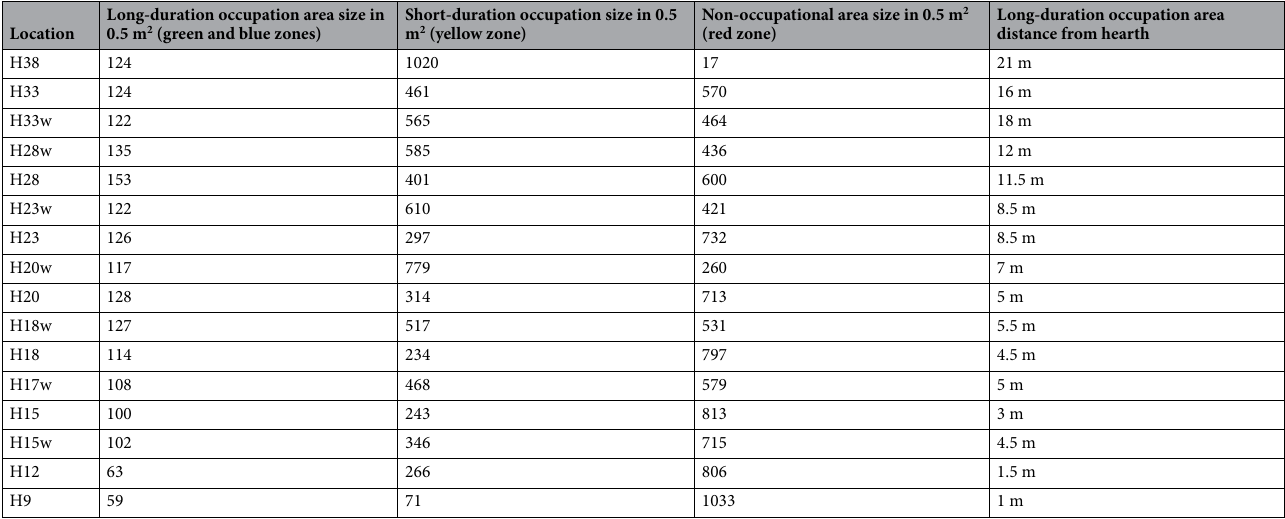
Table 1. Results for smoke density from sensors at 1.5 m